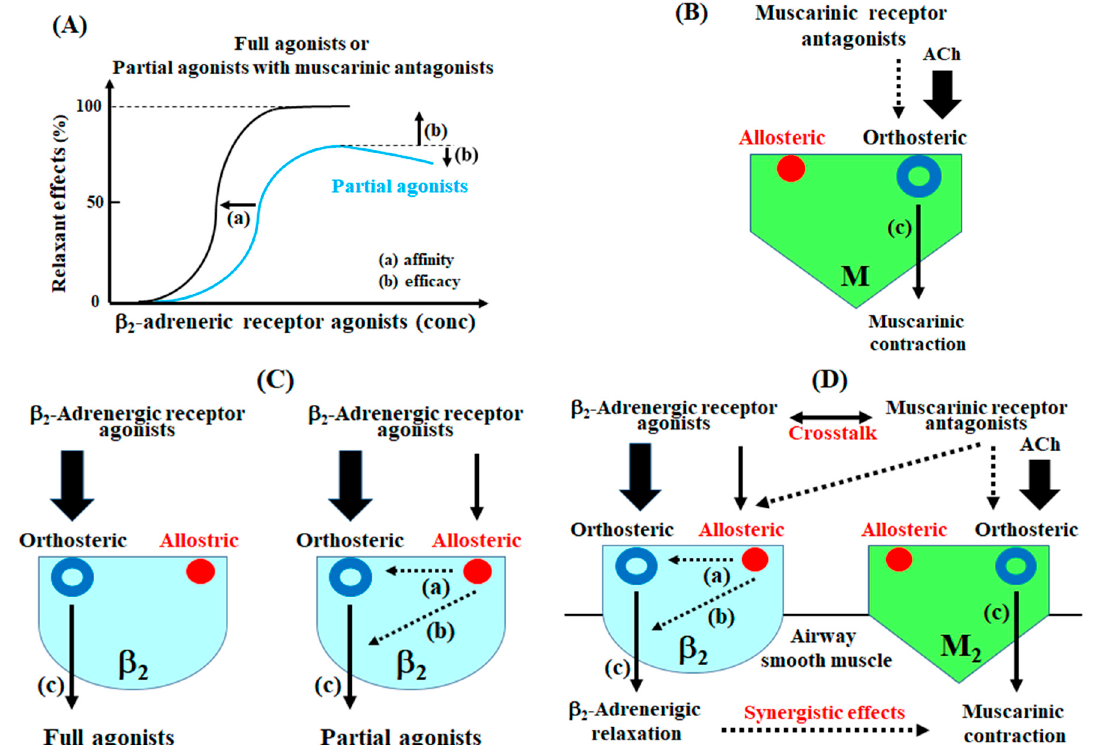
Figure 7. Involvement of allosteric effects (affinity and efficacy modulation) in response to β 2 -adrenergic receptor agonists and muscarinic receptor antagonists against muscarinic contraction. ( A ) A schema of affinity and efficacy modulation via allosteric sites shown in concentration-response curves for β 2 -adrenergic receptor agonists against muscarinic contraction; ( B ) Muscarinic receptor antagonists inhibit muscarinic action via acting on orthosteric sites on muscarinic receptors, independent of allosteric sites; ( C ) Full β 2 -adrenergic receptor agonists do not act on allosteric sites. In contrast, partial β 2 -adrenergic receptor agonists act not only on orthosteric sites, but also on allosteric sites on these receptors, and these agonists reduce the signal capacity (intrinsic efficacy) of an orthosteric ligand via efficacy modulation induced by operating upon allosteric sites; ( D ) Muscarinic receptor antagonists act on allosteric sites of β 2 -adrenergic receptors, and as a result affinity and efficacy of β 2 -adrenergic receptor agonists are enhanced, leading to the synergistically relaxant action of the combination of β 2 -adrenergic receptor agonists with muscarinic receptor antagonists via crosstalk of these two receptors. M: muscarinic receptors, β 2 : β 2 -adrenergic receptors, M 2 : muscarinic M 2 receptors. ( a ): affinity, ( b ): efficacy, ( c ): signal capacity (intrinsic efficacy). Arrows: activation, dotted arrows: inhibition.